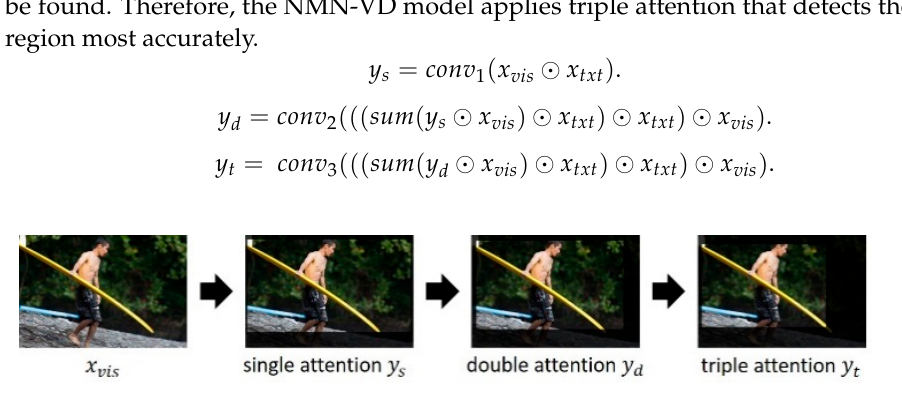
Figure 9. Attention